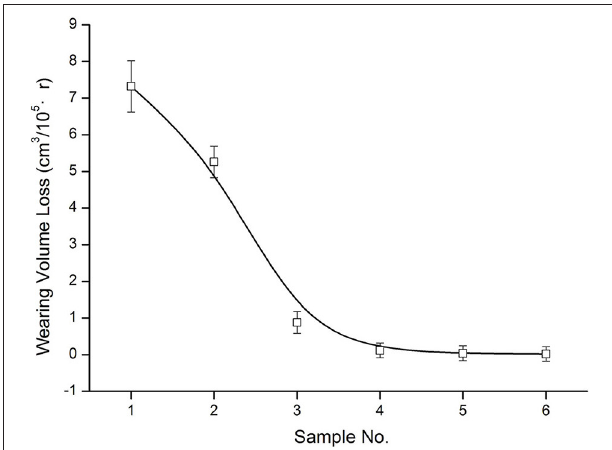
FIGURE 8 | Relationship of wearing volume loss against Mo 2 C content:(1) 0% Mo